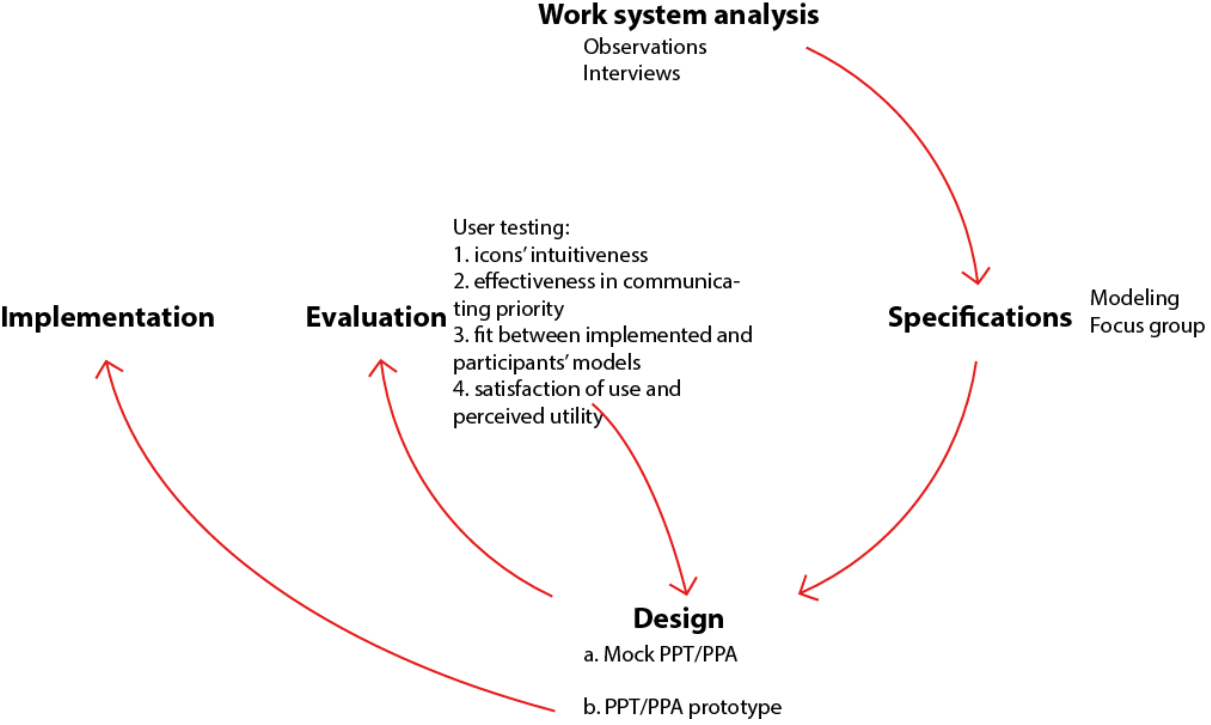
Figure 1. Representation of the human-centered design process applied during the study. First, a work system analysis was performed through observations and interviews. Then specifications were developed using modeling and a focus group session. A mock PPT/PPA was designed and then evaluated by user testing. Results from the evaluation helped improve the usability of the PPT/PPA prototype before implementation. PPA: patient prioritization algorithm; PPT: patient prioritization